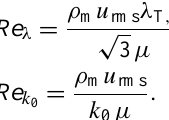
Figure 2. Isosurface at Q u (cid:39) 19Hz 2 and t/τ e (cid:39) 2 . 2, representing zones with coherent vortices.